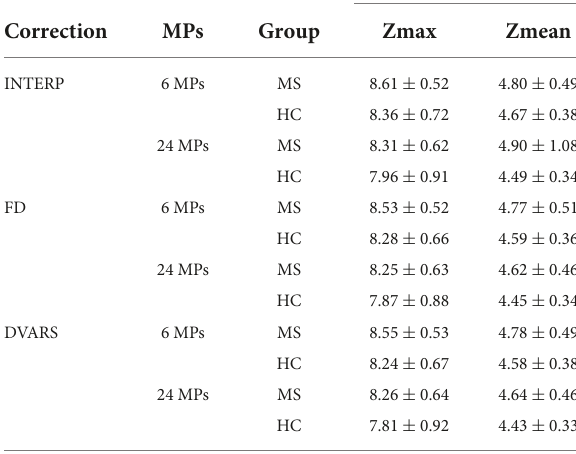
TABLE 3 Metrics to assess the quality of the models using a combination of 6 MPs or 24 MPs with each method to correct the motion outliers’